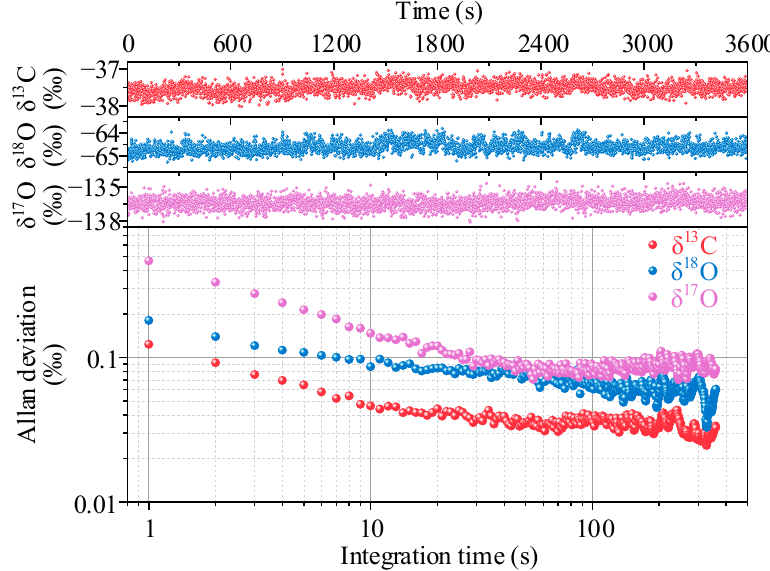
Figure 9. Raw measurement results of δ 13 C, δ 18 O, and δ 17 O ( upper panels ) and Allan deviation plot as a function of integration time ( lower panel )